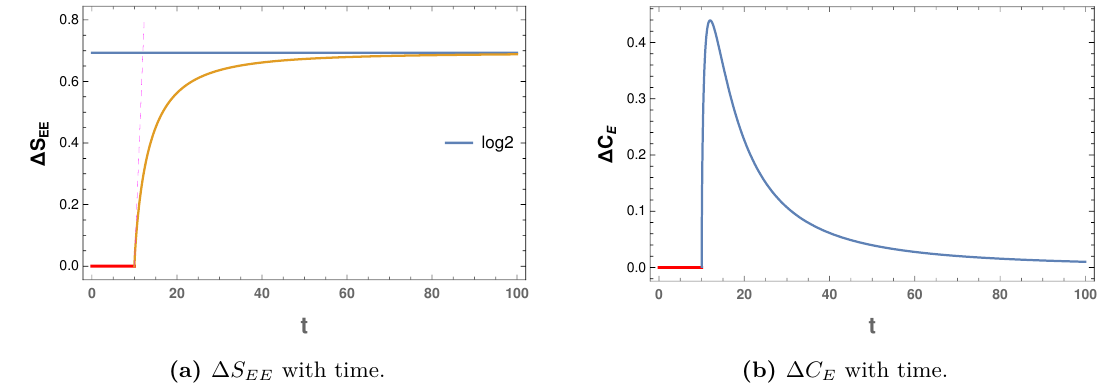
Figure 6. Plot of (a) entanglement entropy and (b) capacity of entanglement for ( γ t γ 1 ) aa = 0 for the uncharged case. Here we choose L = 10 . At t ≈ 11 . 9968 , capacity reaches a peak where the “Page transition” occurs and dies off late. The entanglement entropy saturates to log 2 . These plots are strikingly similar to the entanglement entropy and capacity plots of the EoW brane model in the microcanonical ensemble [24].